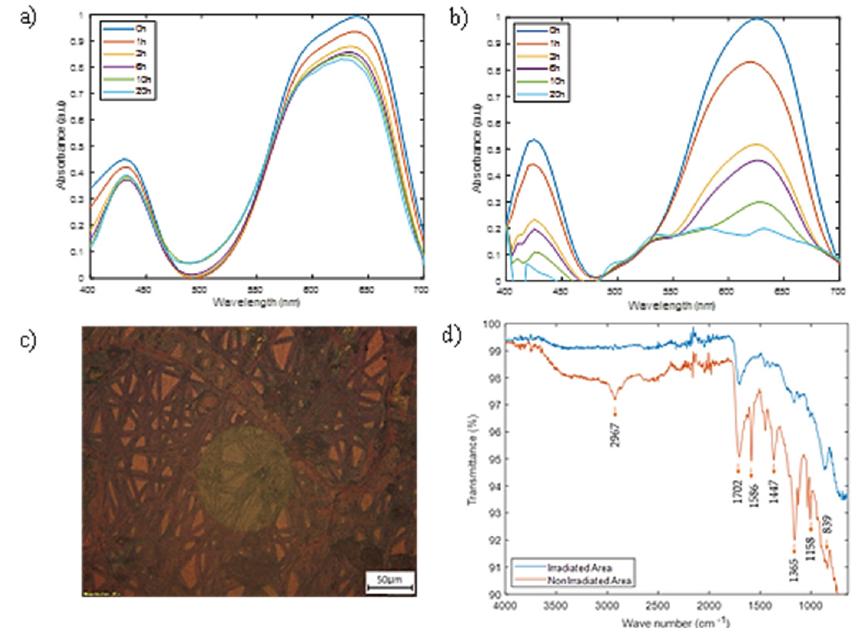
Figure 8. ( a ) Evolution of the degradation rate of MG deposited into S0 sample S0 for a total irradiation time of 20 h; ( b ) evolution of the degradation rate of MG deposited into S2 sample for a total irradiation time of 20 h; ( c ) optical microscopy image of a micrometric degraded zone of the dye; ( d ) FTIR spectra of the irradiated and non-irradiated area of the Malachite Green sample.